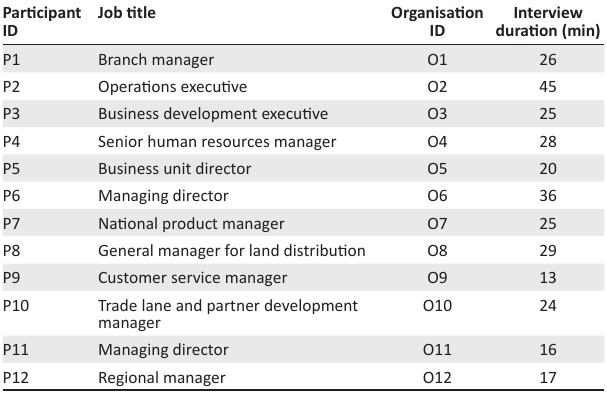
TABLE 1: Description of the participants’